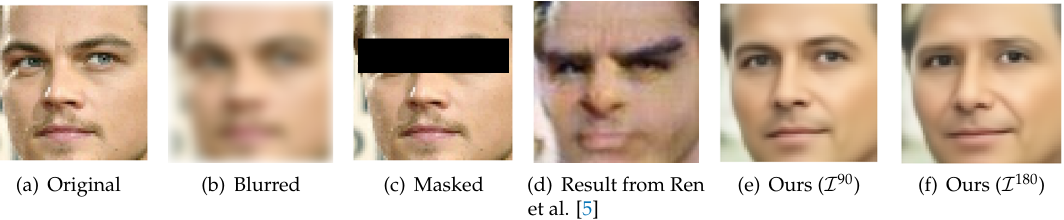
Figure 1. Comparison of various face de-identification methods: ( a ) input image, ( b ) blurred image, ( c ) masked image, ( d ) de-identified image by a generative adversarial networks-based method [5], ( e , f ) de-identification results from the proposed method by rotating the disentangled identity-related latent vector 90 and 180 degrees, respectively. As it can be seen from the figures, the proposed method results in more natural facial images while the identity is effectively